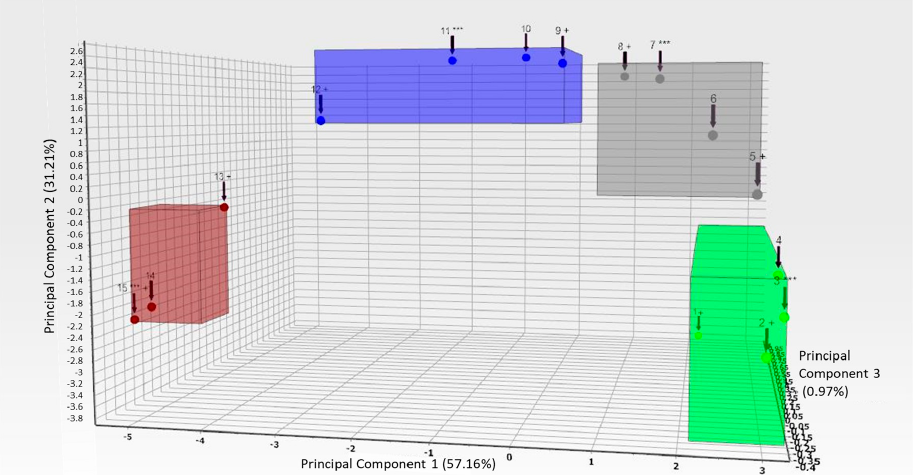
Figure 12. Clustering of triphylite–quartz mixtures showing four different lithium ore grades. *** most representative Scheme 2. contents, low triphylite, medium triphylite, and high triphylite contents. The XRD patterns of these mixtures and their calculated groups, including their similarities, are given in Figure 13. To show the relevant main peaks of the mineral quartz in these mixtures, with special emphasis to low amounts, Figure 14 is added.